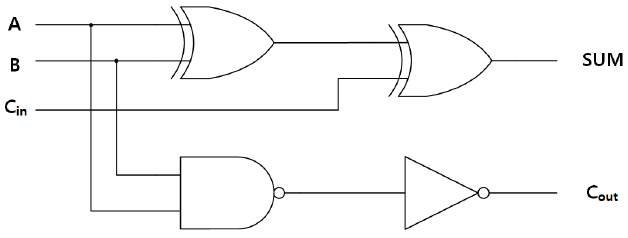
Figure 6. Schematic of AFA 3 [15].